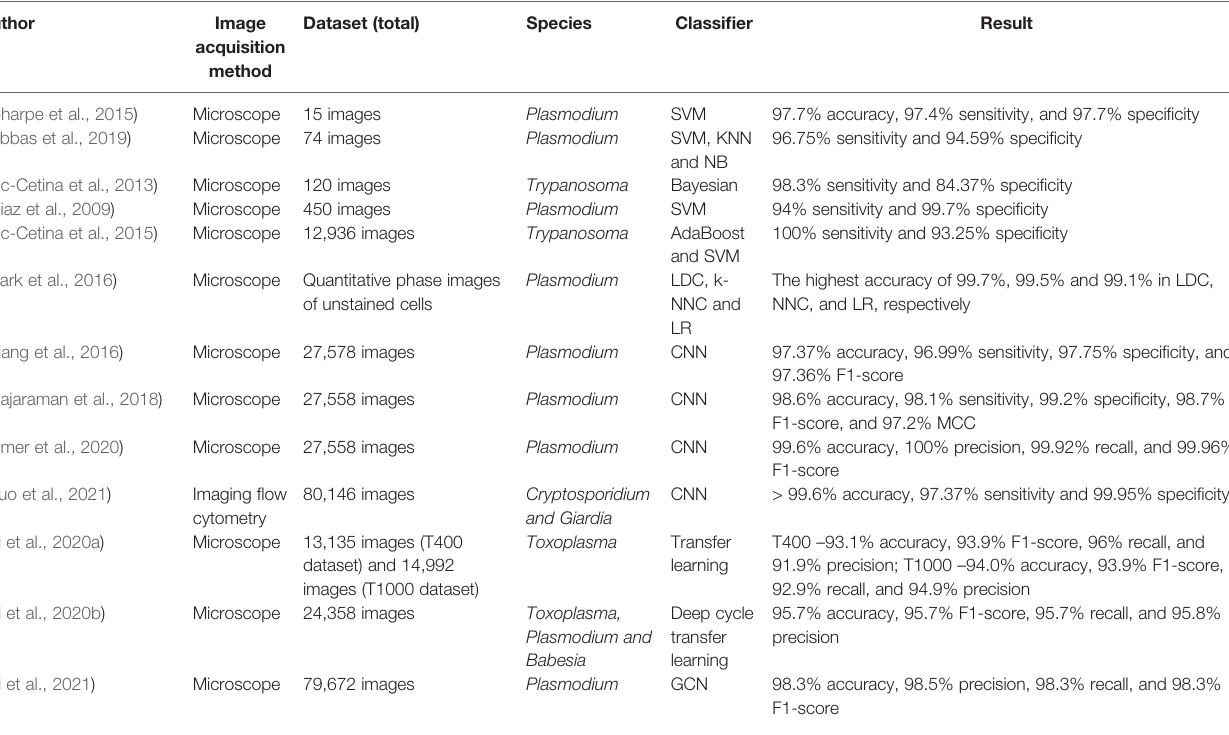
TABLE 2 | Representative arti fi cial intelligence applications for protozoal pathogen detection in